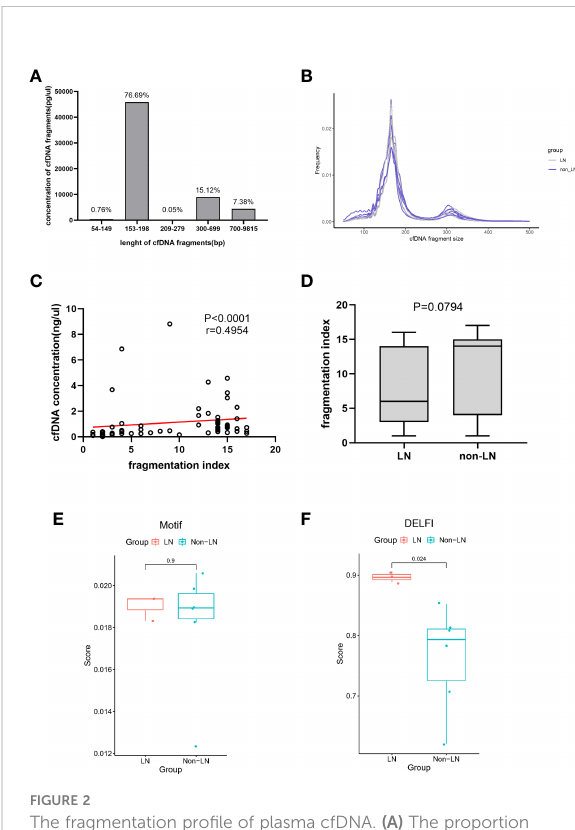
FIGURE 2 The fragmentation pro fi le of plasma cfDNA. (A) The proportion of cfDNA of different fragment lengths. Data was generated using a High Sensitivity DNA chip on the Agilent 2100 Bioanalyzer using 35- and 10380-bp markers. (B) cfDNA fragments lengths were shown for lupus nephritis (LN) individuals (n=3, gray) and non-LN individuals (n=6, blue). (C) Linear correlations between the cfDNA concentration and the fragmentation index ( r = 0.4954, P < 0.0001). (D) The fragmentation index in the LN group was similar to that of the non-LN group (6 ([3-14] vs 14 [4-15]; P = 0.0794). (E) The mean of the Motif scores were similar in the two groups (0.0190 vs 0.0182; P =0.9048). (F) The mean of the DELFI scores in the LN group was signi fi cantly higher than that in the non-LN group (0.8970 vs 0.7632; P = 0.0238).